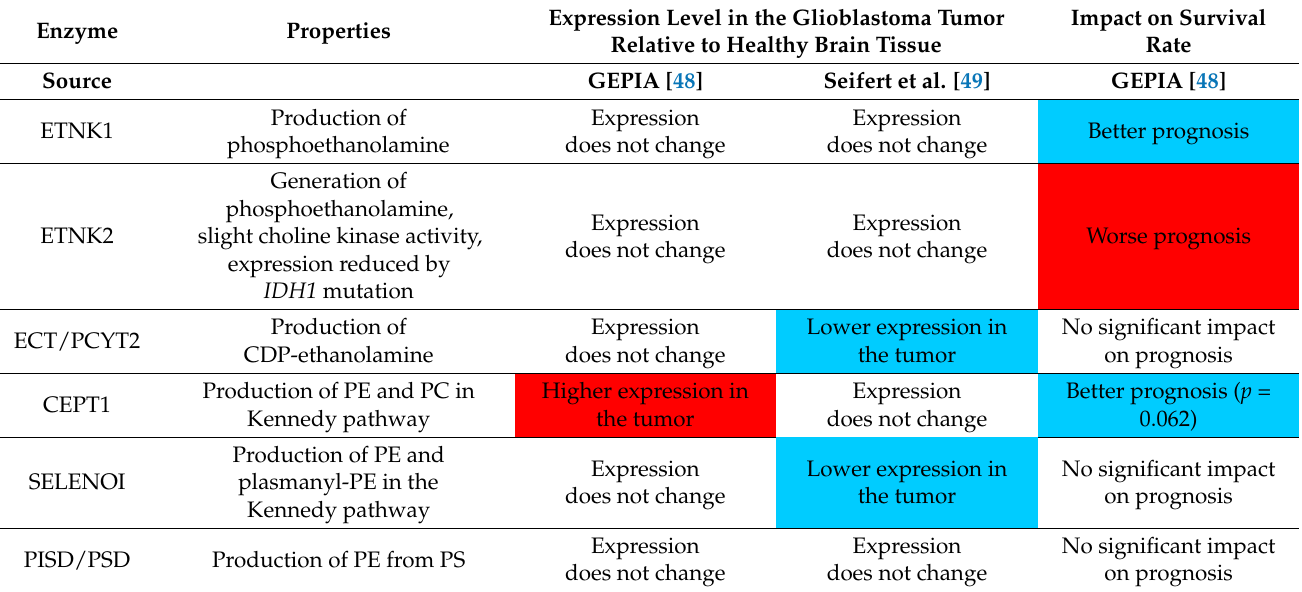
Table 7. Characteristics of enzymes involved in PE